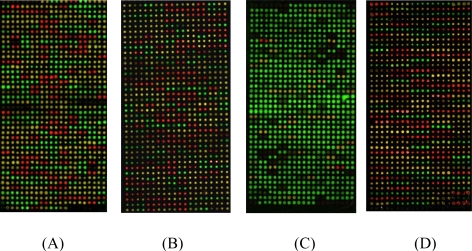
Hybridized image of four SNPs of BDNF gene for part of samples.The images acquired by the confocal scanner which was fitted with filters for Cy3 and Cy5. The green spots indicate wild homozygous, the red spots indicate mutant homozygous, and the yellow spots indicate heterozygote. (A) scan image of rs988748, (B) scan image of rs2049046, (C) scan image of C270T, (D) scan image of rs6265.